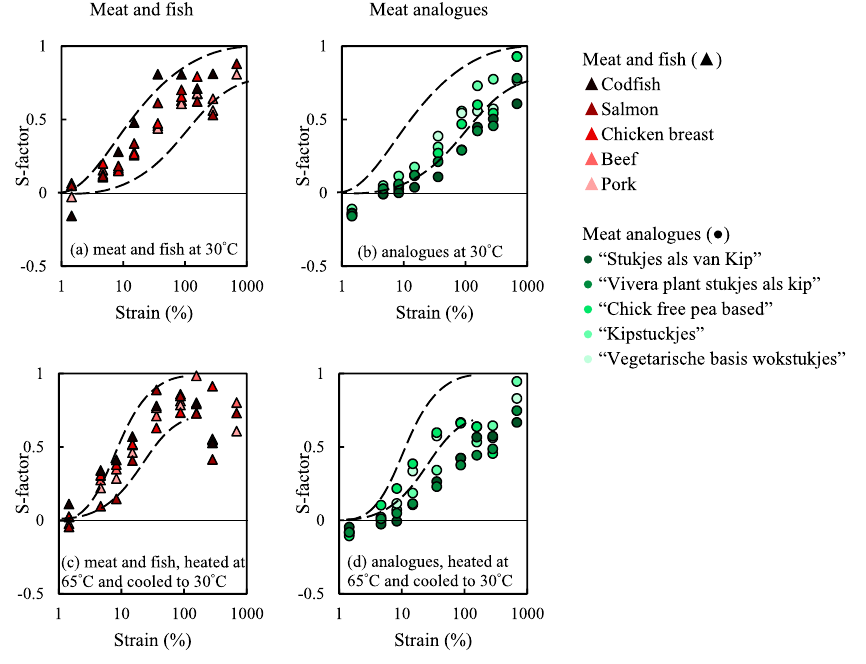
Figure 6. Stiffening ratio (S-factor) as a function of strain amplitude for meat and meat analogues. Dashed lines are drawn to guide the eye and show the outlines for the highest and lowest values of meat and fish from the meat analogues